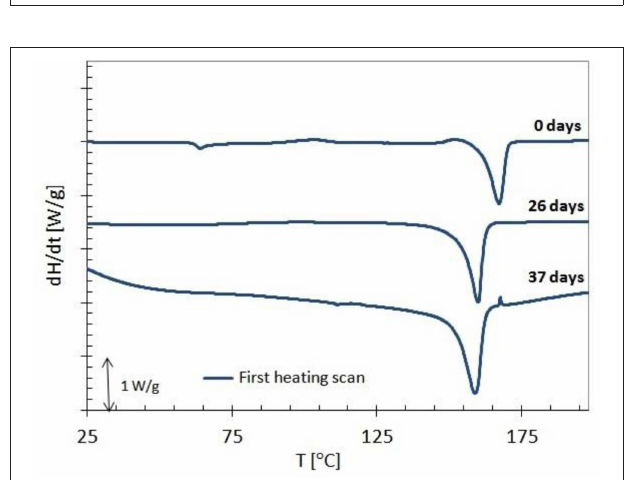
FIGURE 11 | Evolution of number average molecular weight (M n ) during hydrolysis of micro-injected biphasic PLA sample (amorphous gate, crystalline